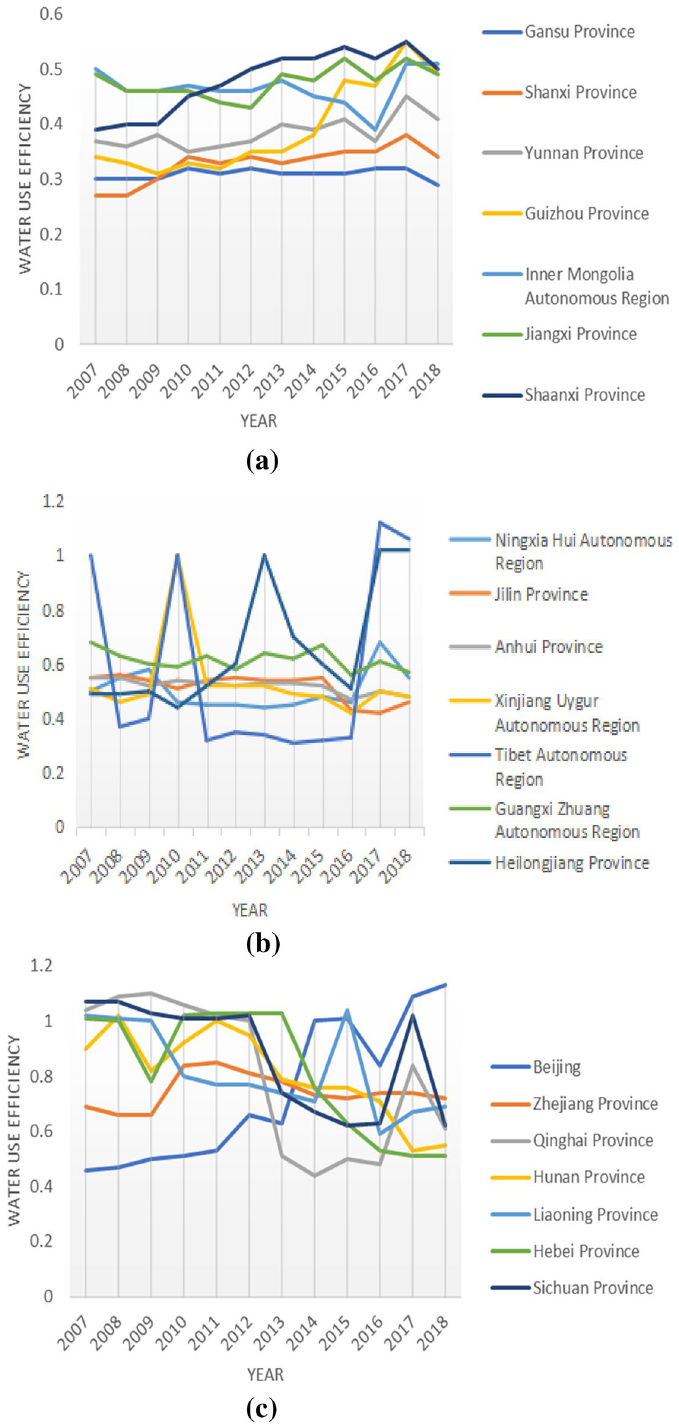
Figure 2. Evaluation of agricultural water use efficiency in different regions. This figure shows the agricultural water use efficiency of 31 provinces, autonomous regions, and cities in China from 2007 to 2018. The above five charts are listed separately according to the average water use efficiency of (a) 0.3–0.5, (b) 0.5–0.7, (c) 0.7–0.9, (d) 0.9–1.1, and (e) 1.1 and